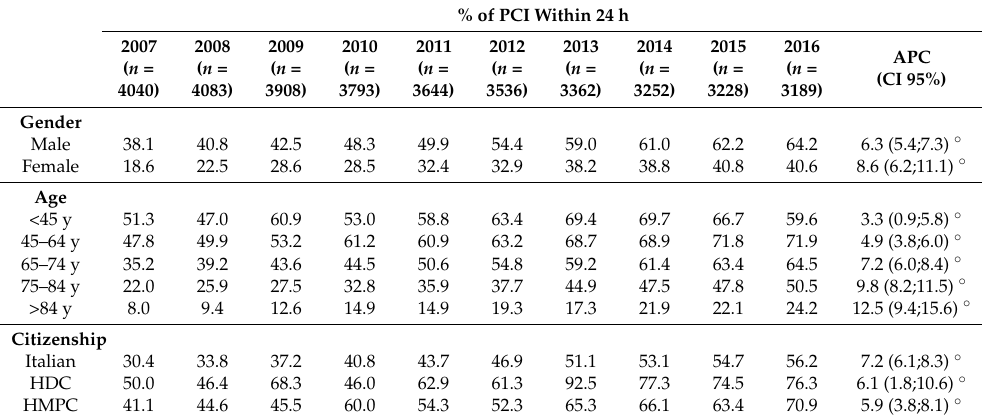
Table 2. Veneto Region 2007–2016. Proportion of PCI within 24 h of hospital admission for STEMI by gender, age, and citizenship. % of PCI Within 24